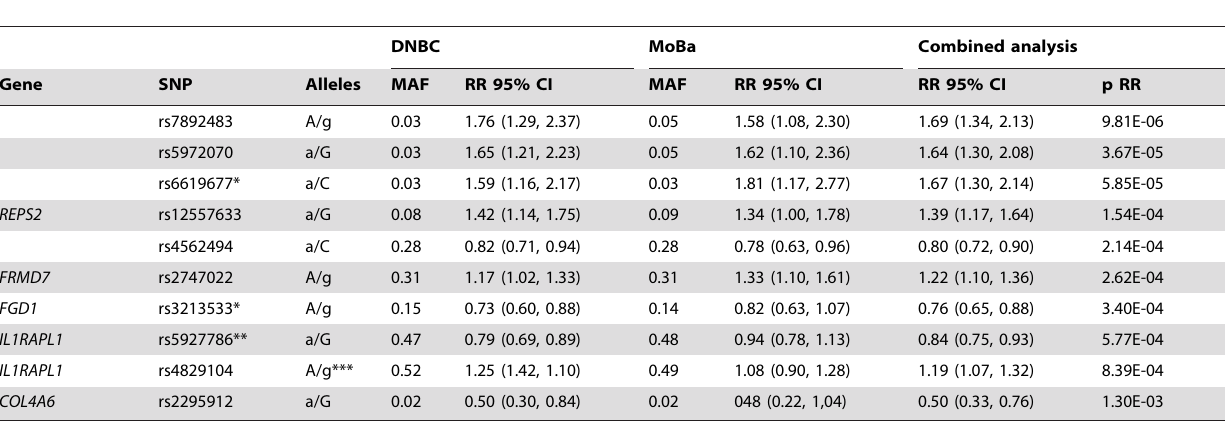
Table 3. Maternal results from the two independent GWAS and the combined